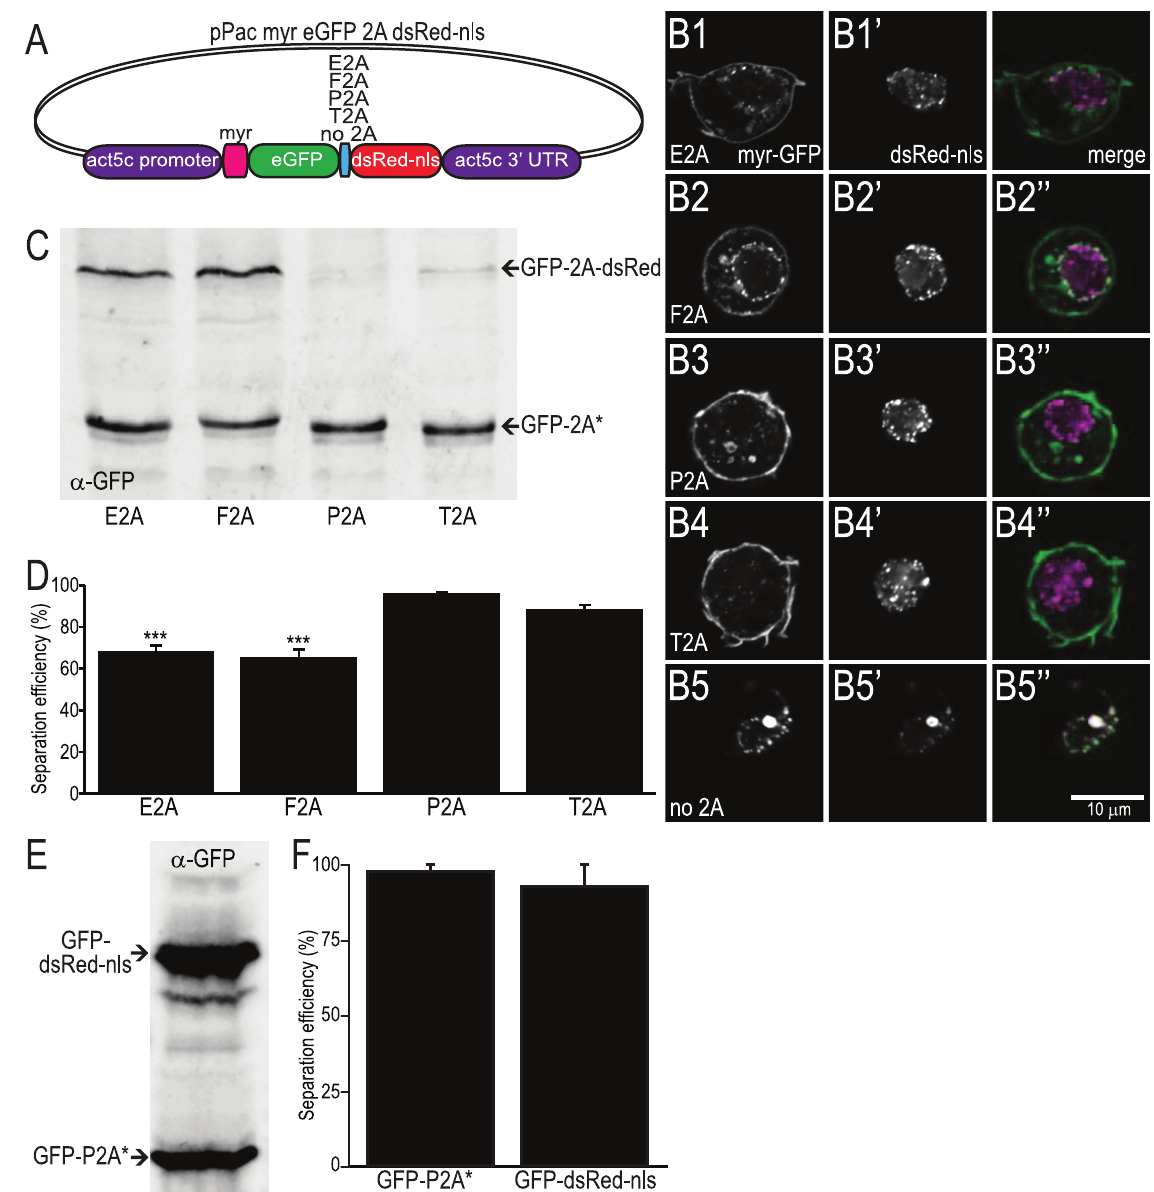
Figure 2. Demonstration of separation of proteins linked by different 2A peptides in cultured cells. A. Diagram of vector used to transform S2 cells to express myristylated GFP and nuclear-localized dsRed. B. Single optical sections from confocal micrographs of fixed S2 cells transfected with vector shown in A. Native GFP and dsRed fluorescence are shown in the leftmost and center panels, respectively. The rightmost panel shows the merged image. While most GFP and dsRed fluorescence is localized correctly, some perinuclear colocalization can be seen. In the absence of a 2A peptide (panel B5), all GFP and dsRed signals colocalize and are enriched in a ring surrounding the nucleus. Similar perinuclear puncta observed in merged image panels (B1’’-B4’’) likely indicate full-length (unseparated) myrGFP-2A-dsRednls protein. C. Example western blot from transfected S2 cells using an anti-GFP antibody demonstrating separation efficiency of different 2A peptides. The top band runs at approximately 75 kDa and is unseparated myrGFP-2A-dsRednls, while the bottom band runs at approximately 37 kDa and is separated myrGFP-2A (GFP-2A*) only. Slight differences in running speed are due to differences in 2A peptide length. D. Histogram showing separation efficiency of 2A peptides tested in S2 cells. Error bars indicate SEM, n=5. The P2A and T2A peptides yield the most complete separation (one-way ANOVA with Bonferonni post-test; p , 0.001 vs. P2A and T2A indicated by asterisks). E. Western blot showing ratiometric expression of proteins before and after 2A peptide. The lower band is GFP-2A and the upper band is GFP-dsRed-nls. F. The intensity of each band was quantified and plotted in the histogram. The average normalized intensity of the lower band is 98 + / 2 2 versus 93 + / 2 7 for the upper band. Error bars indicate SEM, n=2. doi:10.1371/journal.pone.0100637.g002 abundance of this upper band varies depending on the particular P2A and 88 + / 2 3% for T2A (average + / 2 SEM, n= 5, p , 0.001 2A peptide sequence; the P2A and T2A peptides yield the best by one-way ANOVA between E2A and F2A compared with either separation efficiency (Figure 2C and D). E2A had an efficiency of P2A or T2A; P2A and T2A were not significantly different). 68 + / 2 3%, compared with 65 + / 2 4% for F2A, 96 + / 2 1% for